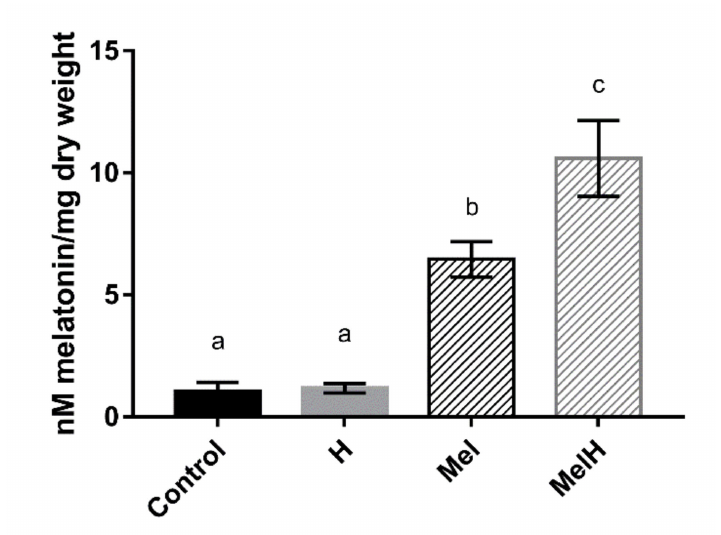
Figure 3. Intracellular melatonin quantification in cells untreated and treated with 5 µ M of exogenous melatonin, before (Control and Mel) and after (H and MelH) being exposed to oxidative stress with 2 mM of H 2 O 2 . Error bars represent standard deviation, letters show statistical di ff erences with p -value <